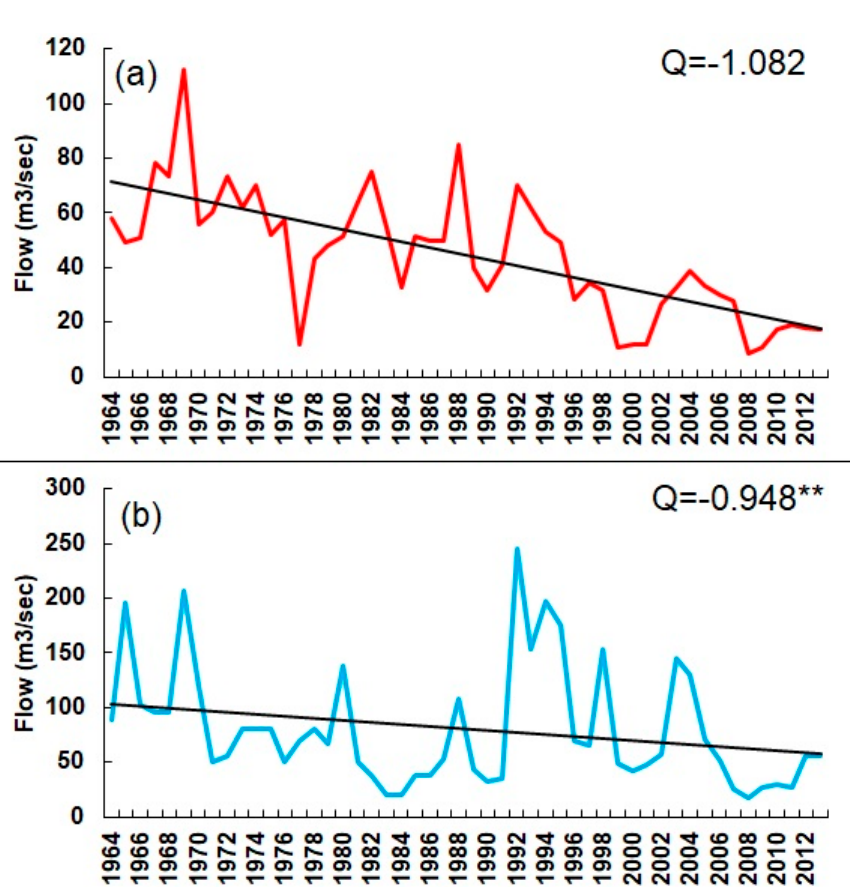
Figure 5. Trends in the minimum annual river flow on the ( a ) upstream and ( b ) downstream sides of Dukan dam.